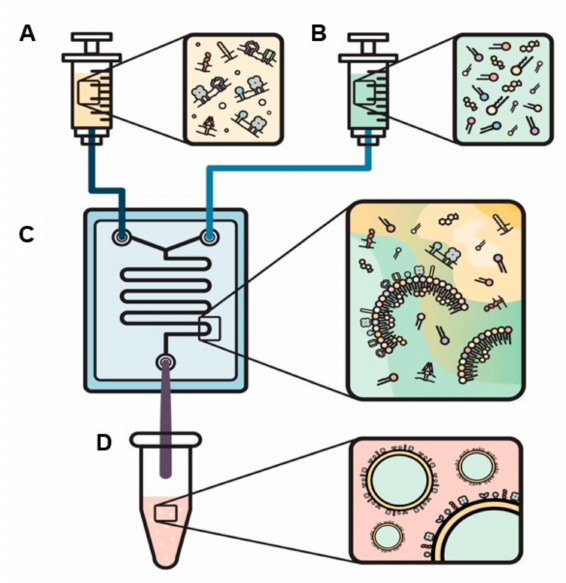
Figure 4. A novel method to actively load proteins into the bilayer of engineered EVs. Solutions are loaded into two separate syringes: (1) proteins within the aqua phase ( A ) and (2) lipids and cholesterol within the organic phase ( B ). The syringes are injected into a chip ( C ) and specific ratios of organic to aqua phases and flow ratio (the speed that the fluids expelled from each syringe mix) are selected to produce biomimetic EVs ( D